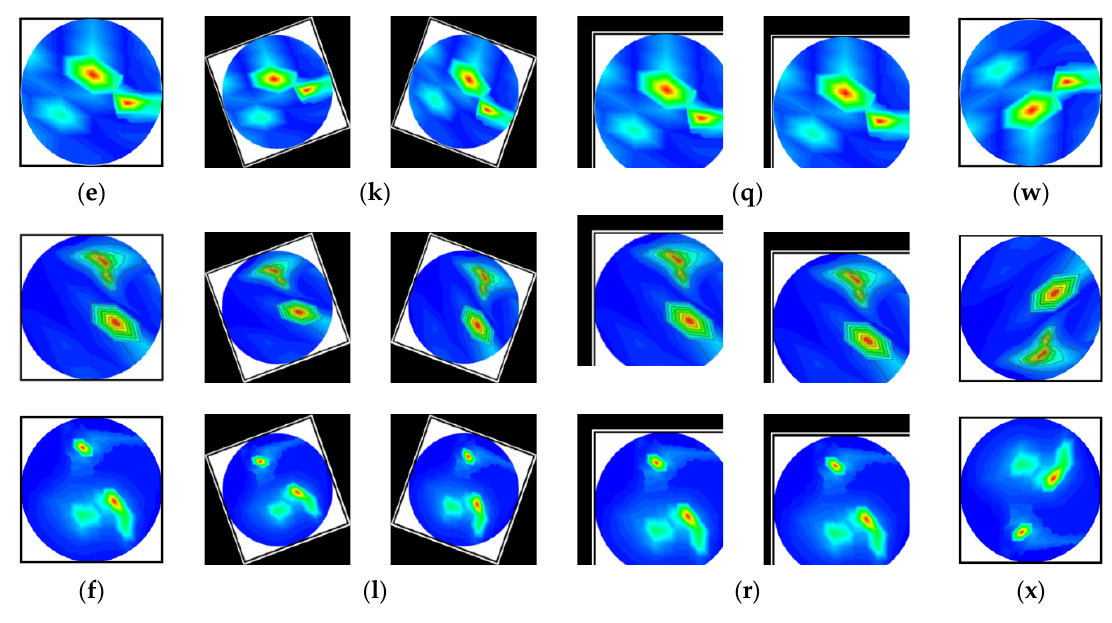
Figure 6. Samples of the augmented training set (six classes): ( a – f ) Pre-processed original images, ( g – l ) After rotating all class images by 30 degrees both clockwise and counterclockwise, ( m – r ) All class images after 10% horizontal and vertical, and 8% horizontal and 12% vertical translation, and ( s – x ) All class images after vertical flipping. Table 2. Description of the training, testing, and validation datasets.